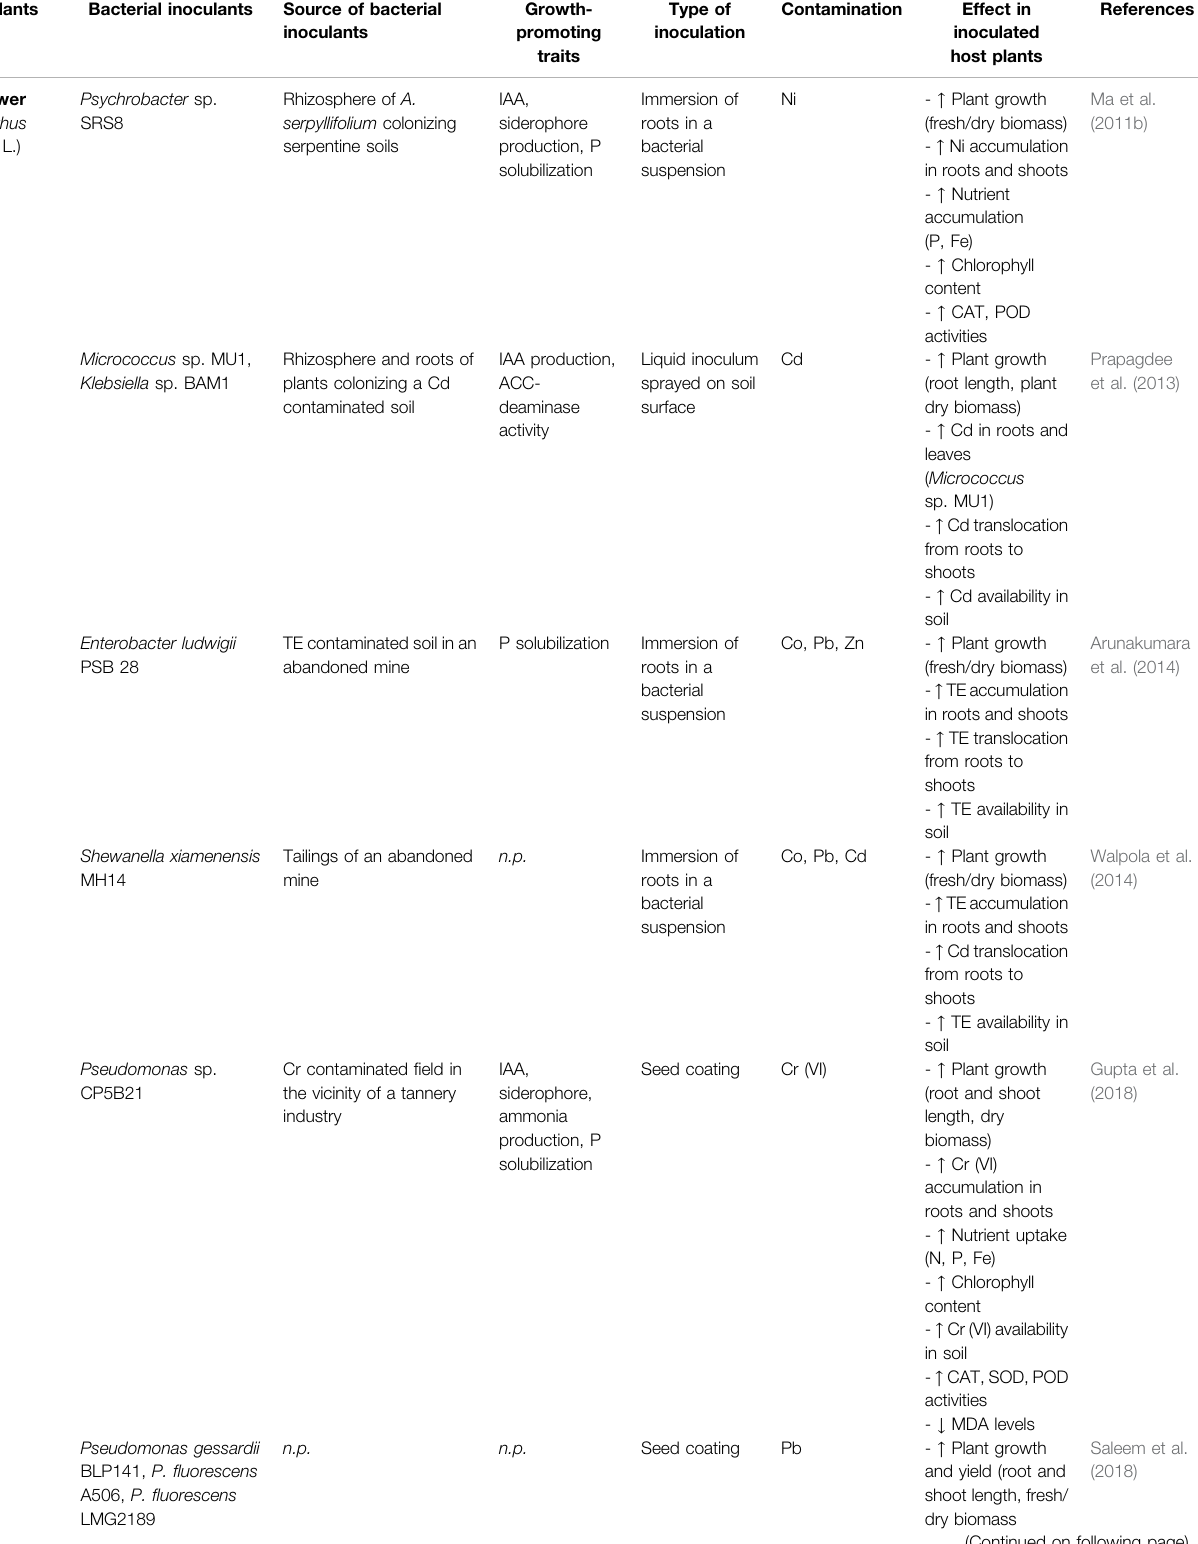
TABLE 5 | Effects of PGPB inoculation on growth and development of economically valuable crops grown under TE-contamination. Host Plants Bacterial inoculants